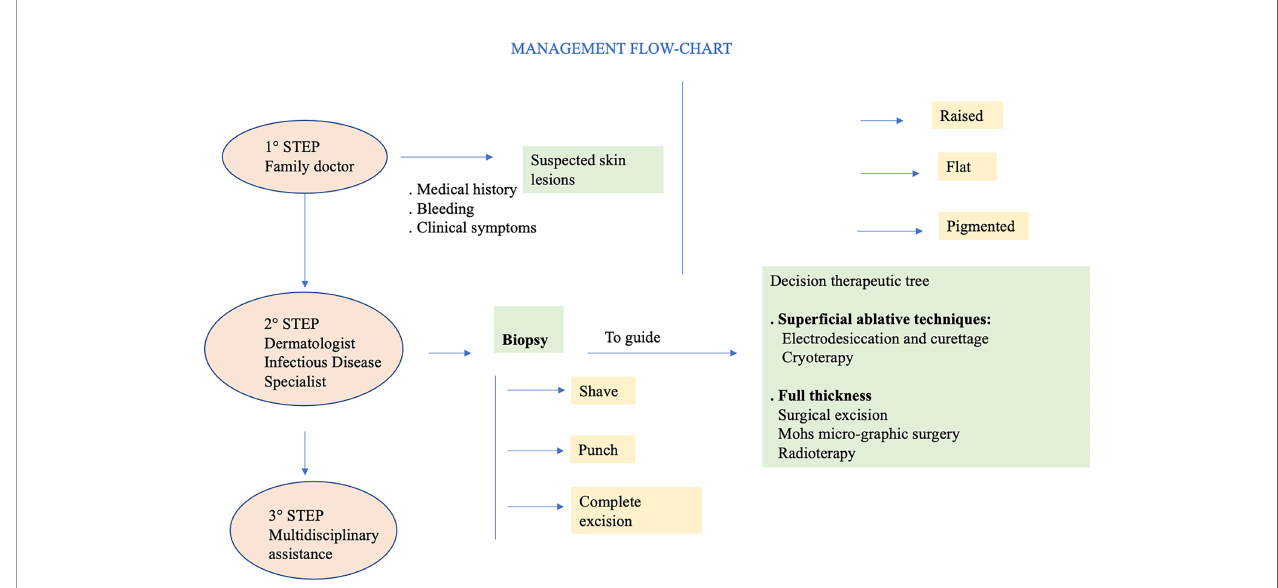
FIGURE 4 | Diagnostic Management fl ow chart of